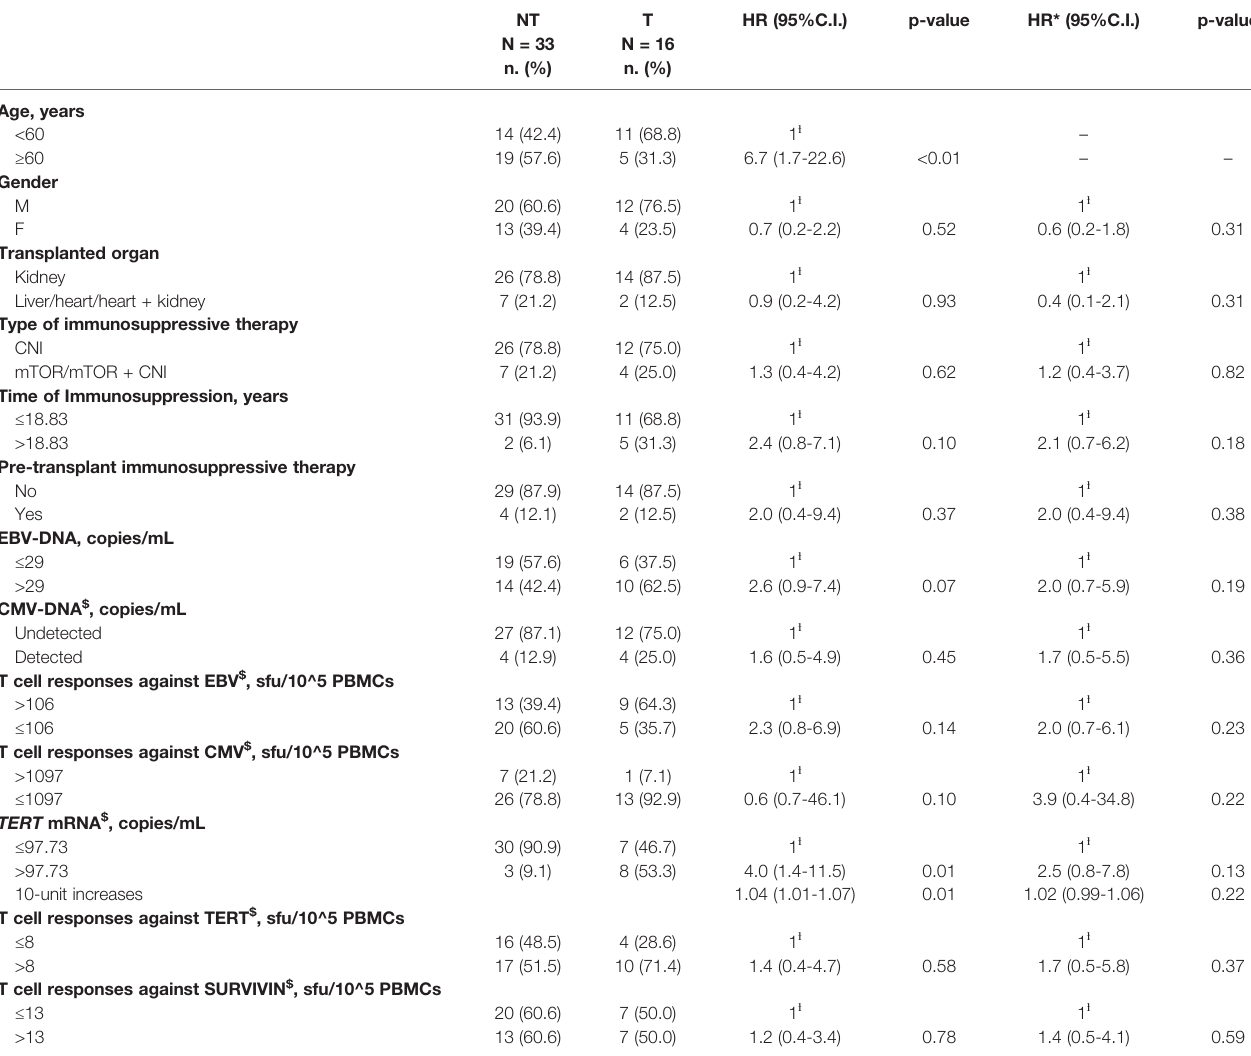
TABLE 3 | Cox regression analysis evaluating the associations between baseline demographic, clinical or biological parameters and tumor onset.